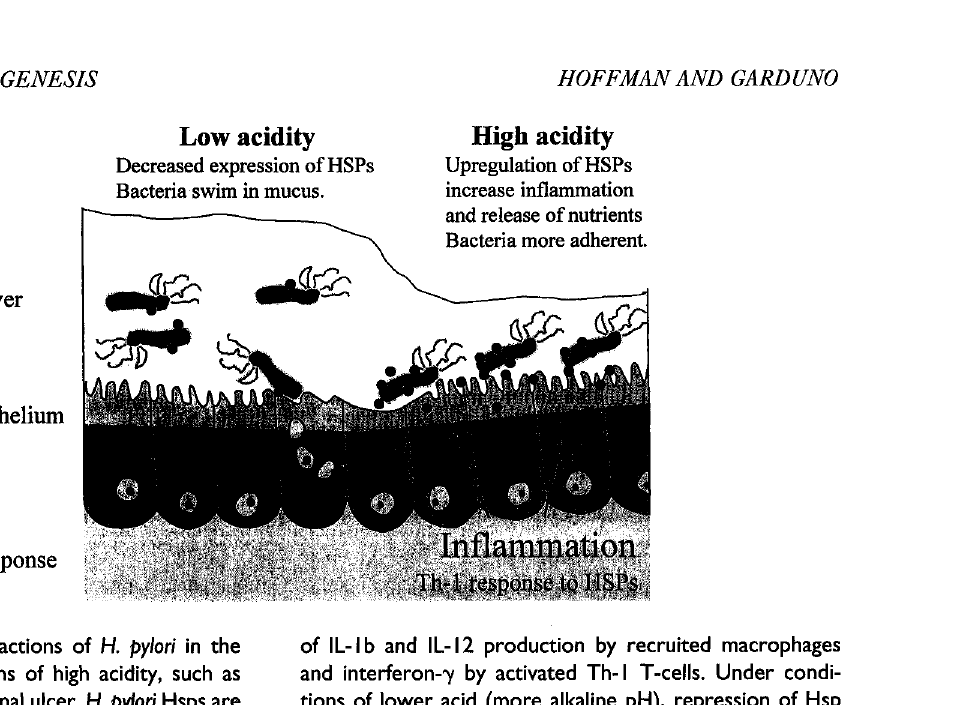
Fig. 3. Illustration of the interactions of H. pylori in the gastric mucosa. Under conditions of high acidity, such as might occur in a gastric or duodenal ulcer, H. pytori Hsps are upregulated and both localized on the surface and released. The increased surface-expressed Hsp60 and Hsp70 pro- mote attachment to the epithelial cells, which might afford protection from the effects of high acid. Released Hsp60 and Hsp70 promote inflammation through the